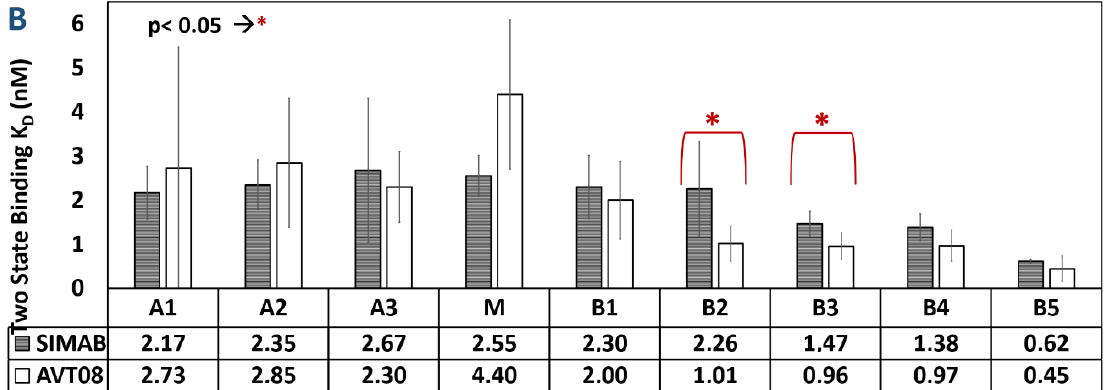
Figure 7. The FcRn-binding characteristics of the fractionated charge variants were revealed by the SPR, using steady-state ( A ) and two-state binding models ( B ). The samples fractionated by the CEX method were obtained from the innovator (AVT08) and the biosimilar candidate (SIMAB054) under the same operational conditions. The A, M, and B represent acidic, main, and basic fractions. A lower K D value represents a better binding. The K D data were given as the mean value obtained from at least five measurements. The inset (top-left) is a representative illustration of the prepared SPR chip surface. The inset (top-right) shows the proposed mechanism of action for FcRn, adapted from reference [108].